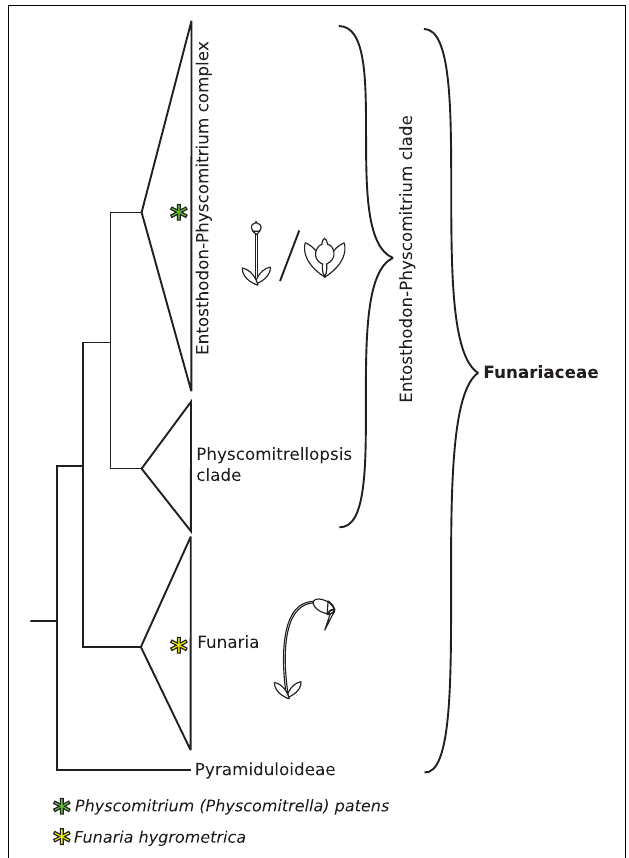
FIGURE 1 | Phylogeny backbone of the moss family Funariaceae, redrawn from Medina et al. (2018, 2019). Species of the Funaria clade show a complex sporophyte phenotype, characterized by an elongated seta and structures aiding controlled spore dispersal (operculum, revoluble annulus, peristome teeth). The Entosthodon - Physcomitrium (EP) clade is mainly comprised of species with an intermediate sporophyte phenotype, lacking one or several structures for improved control of spore dispersal and displaying an overall reduced size. Within the EP clade severe reduction of sporophyte complexity occurred at least four times independently. These highly reduced sporophytes are short and lack specialized structures aiding spore dispersal, mainly forming simple, indehiscent